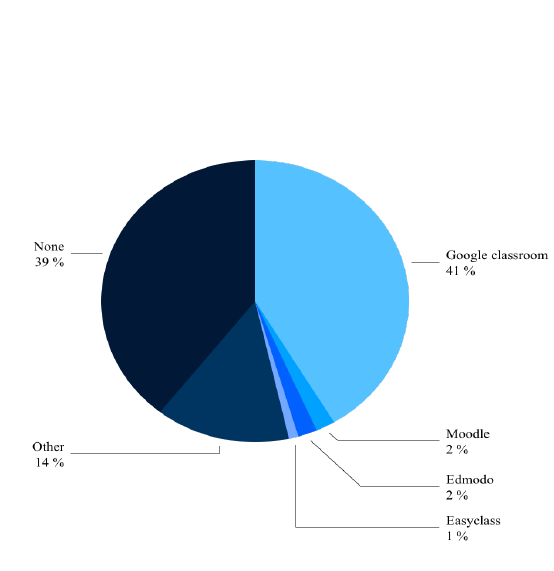
Figure 7. Leading online learning platforms